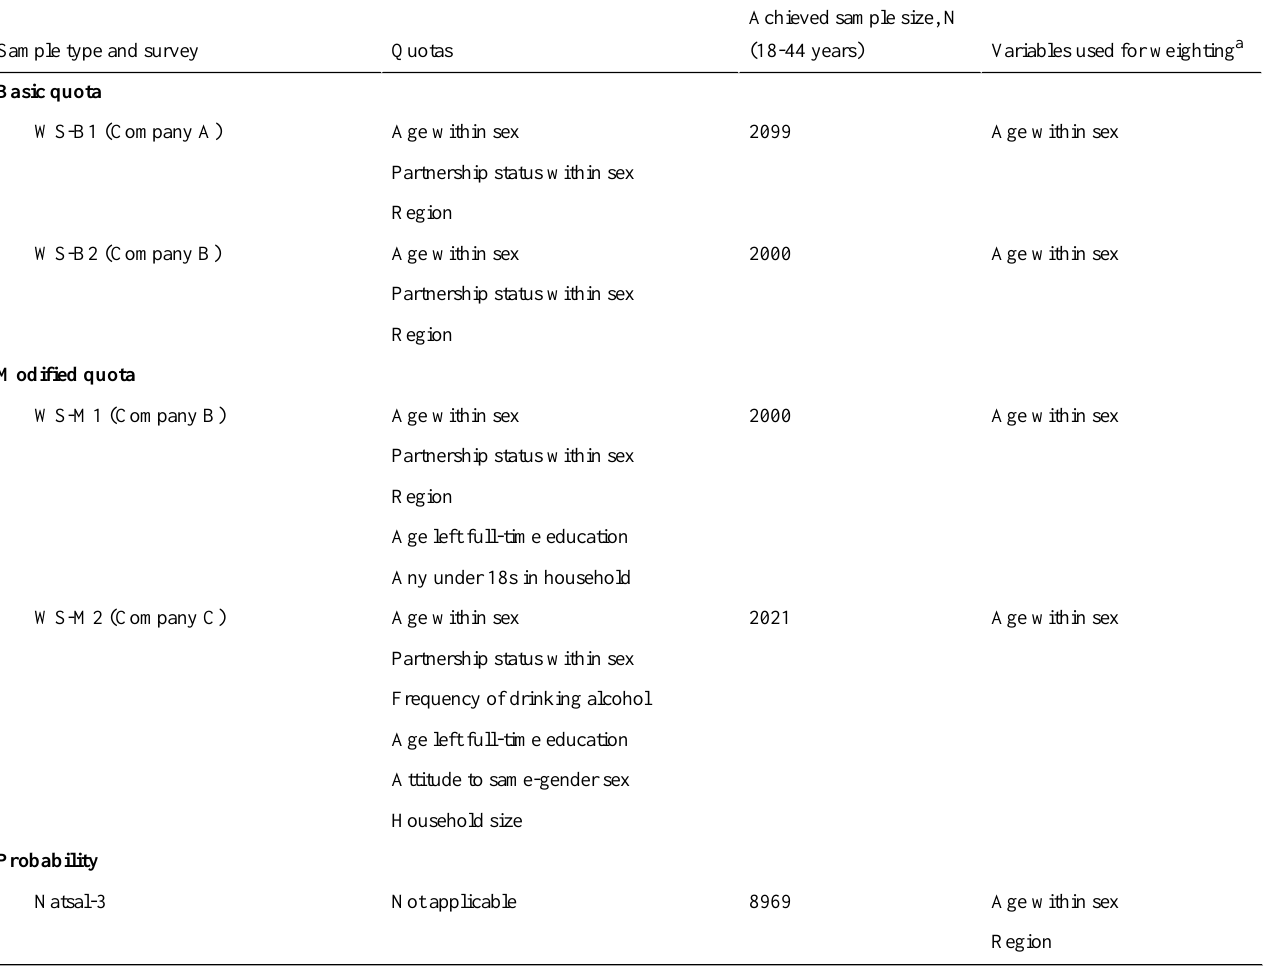
Table 1. Description of the surveys included in the